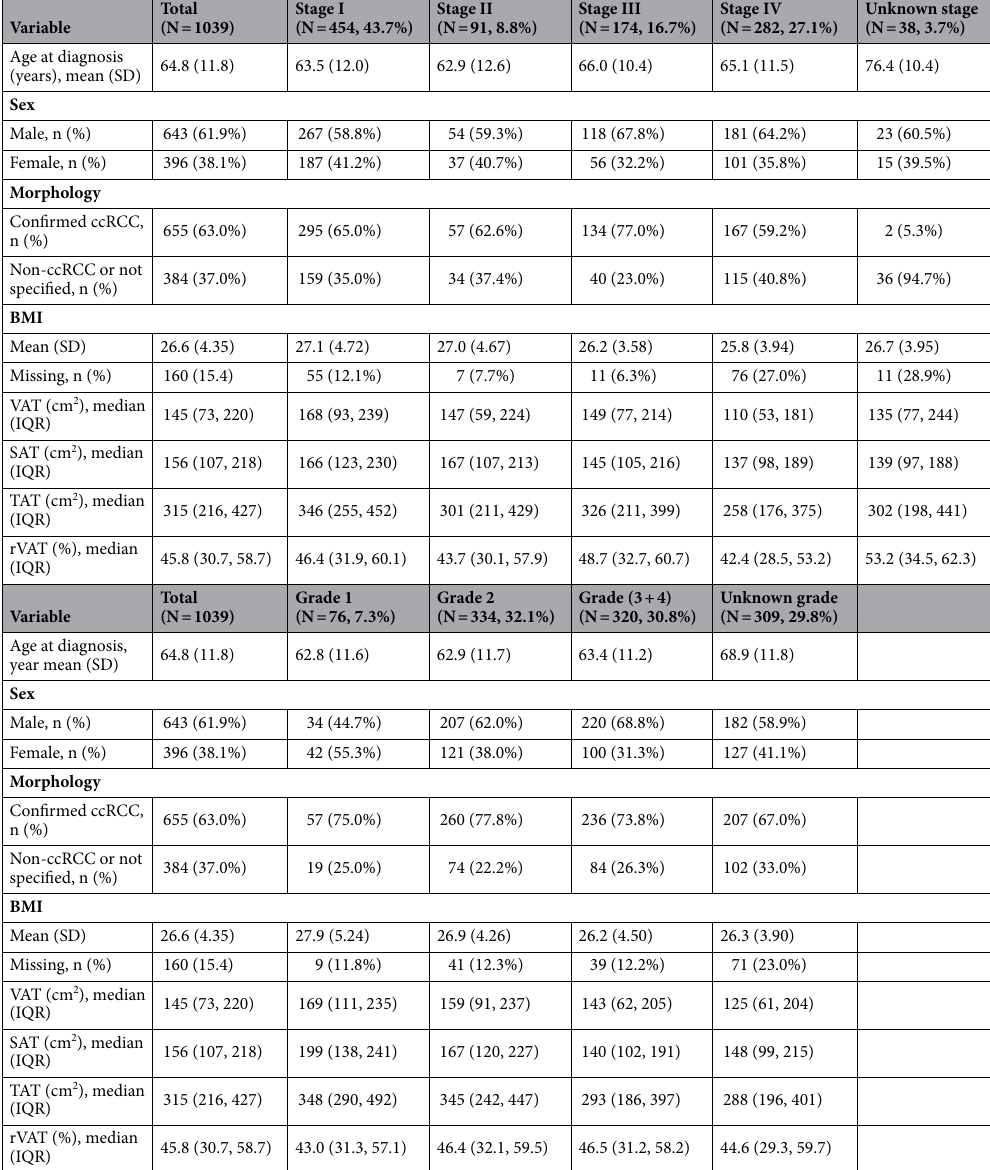
Table 1. Basic characteristics and body adipose tissues per TNM stage a and Fuhrman grade. ccRCC,